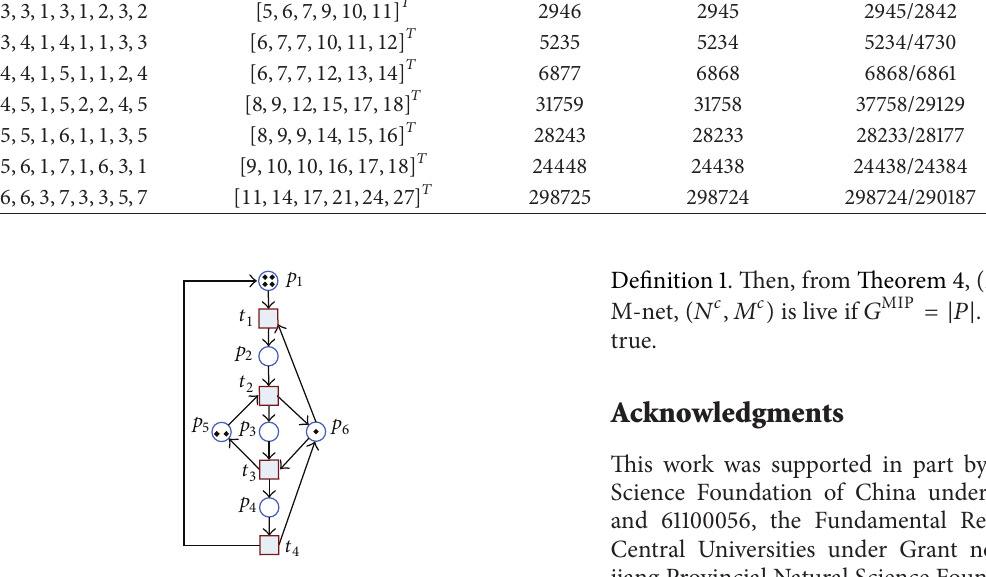
Figure 7: An M-net